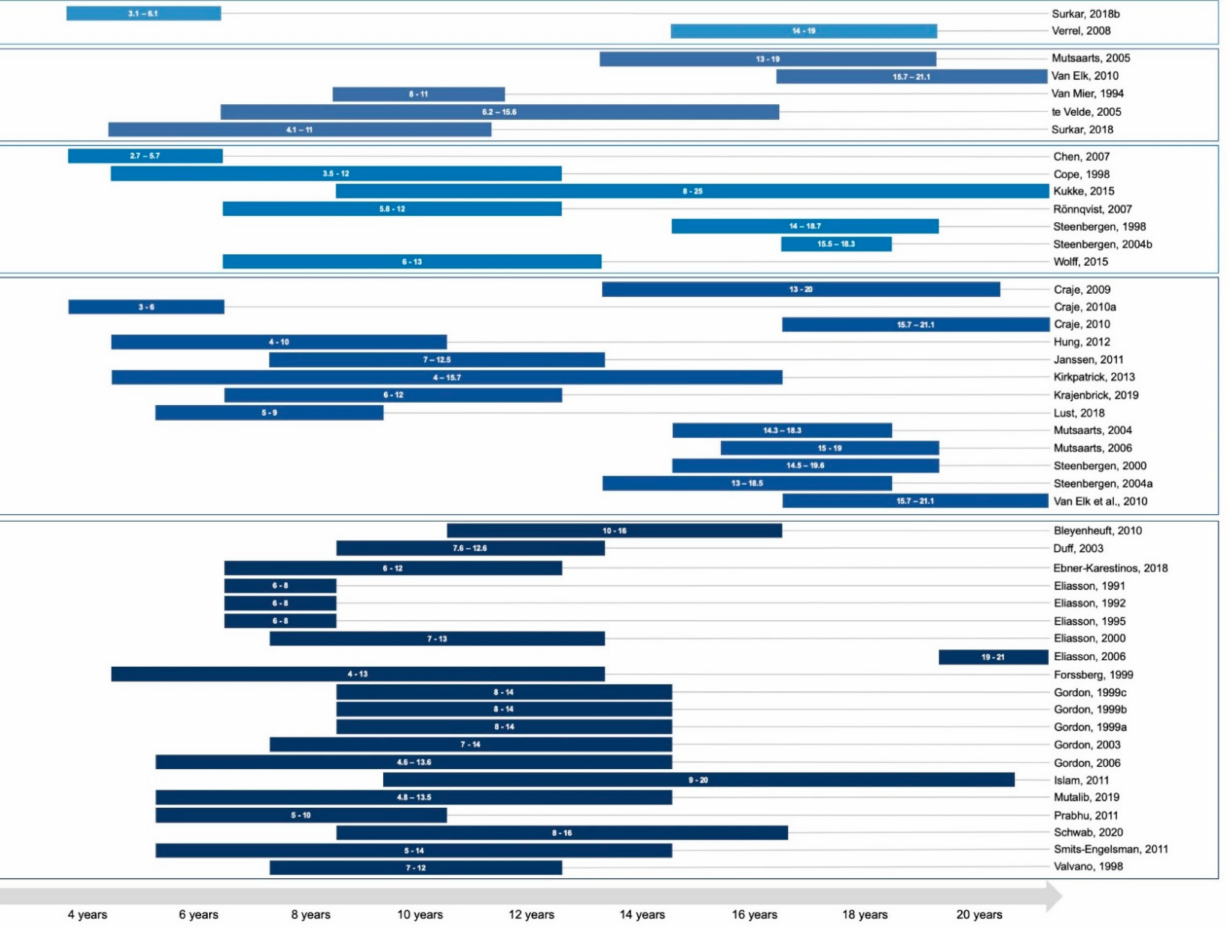
Figure 4. Age tested for each study in each motor planning variable. RT = reaction time; VM =